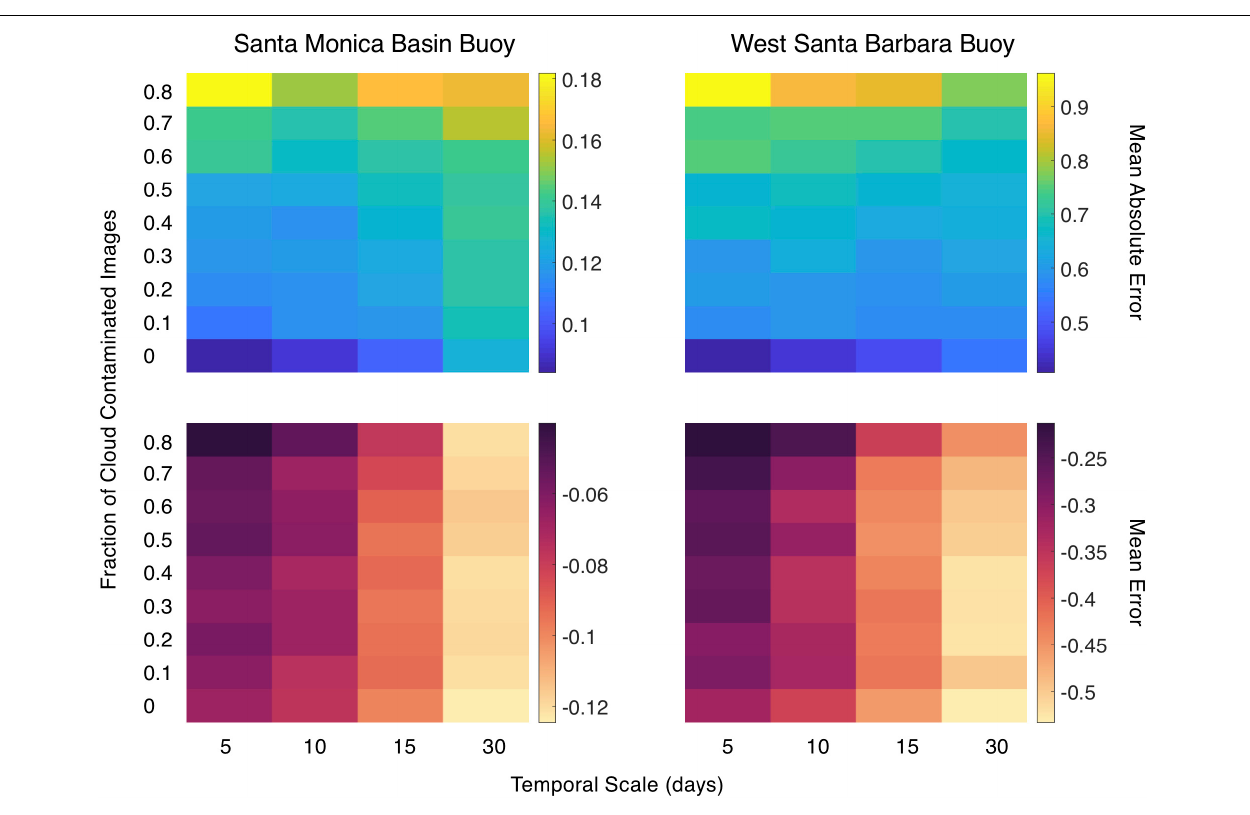
California Bight during these negative NPGO periods, however, Lester et al. (2018), showed that finfish aquaculture may benefit from warmer waters, conditions that would be common